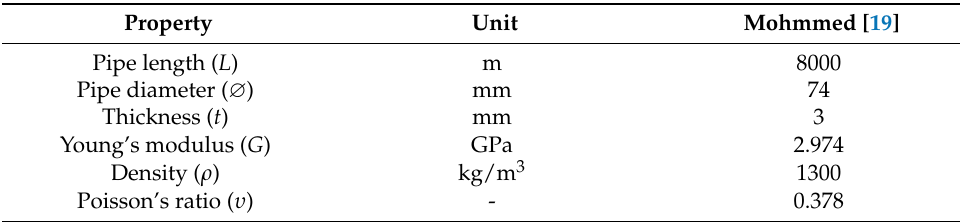
Table 1. FEA model’s piping geometry and physical properties.